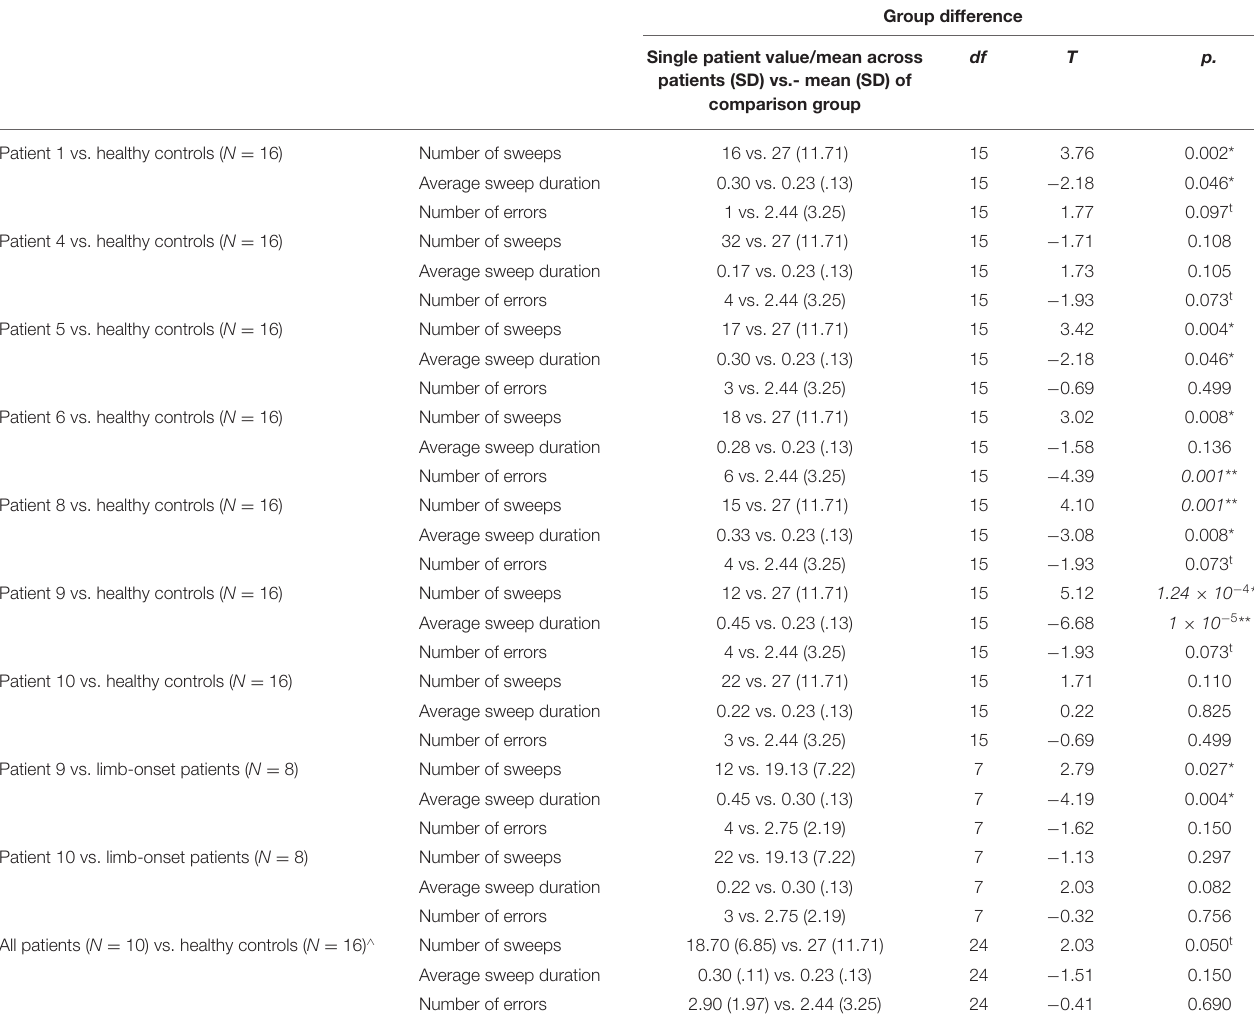
TABLE 4 | Overview over tongue kinematic features.